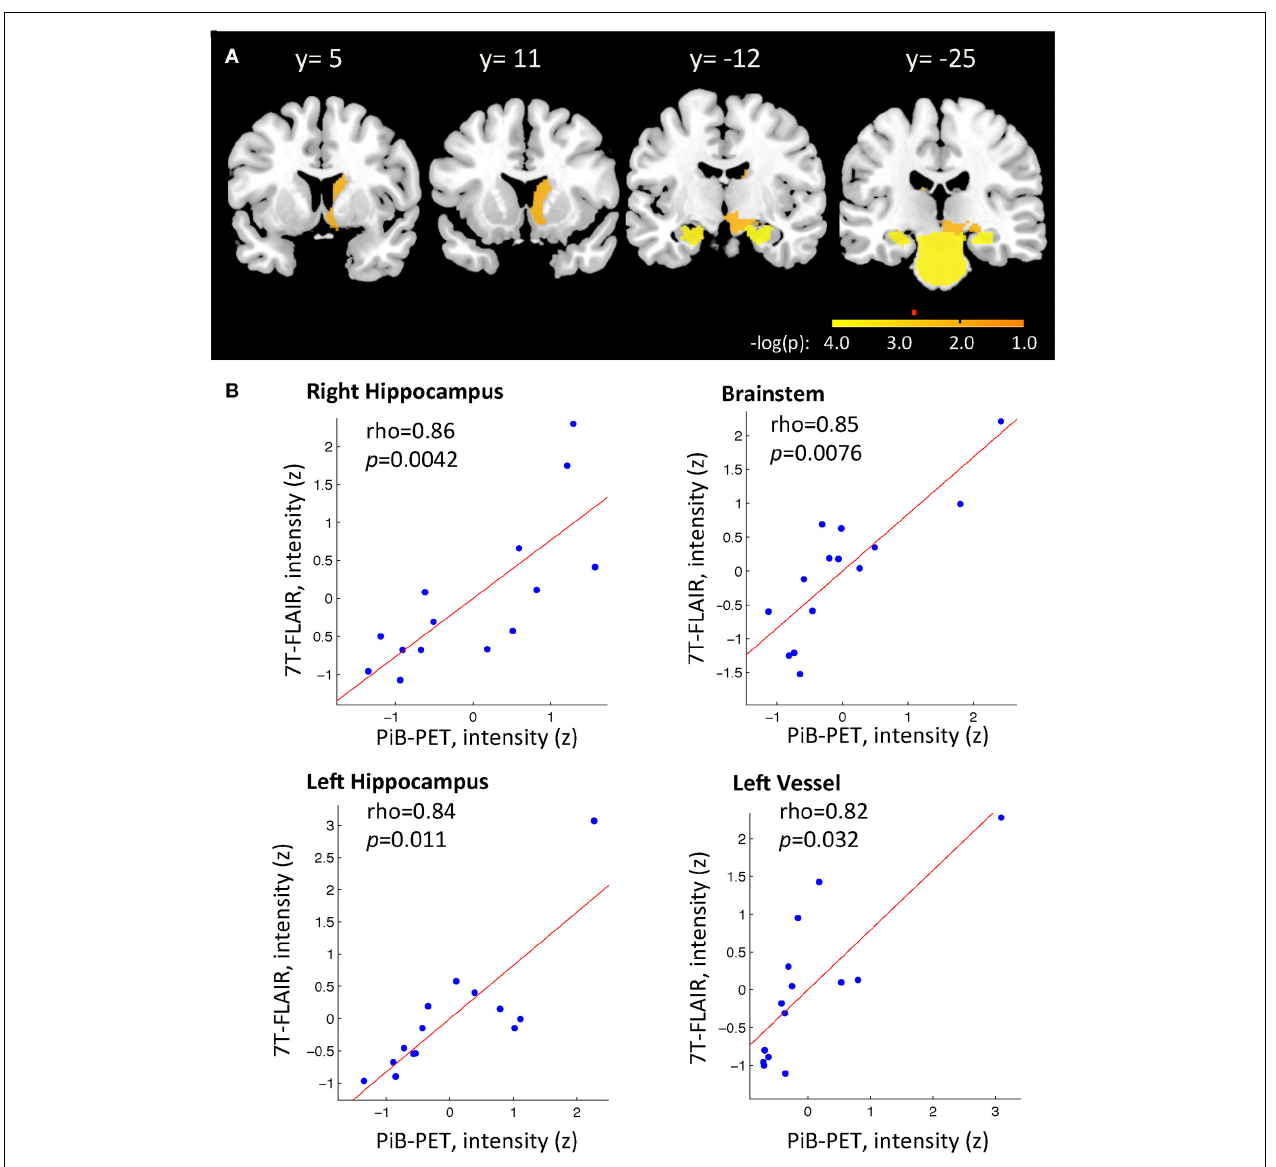
FIGURE 3 | (A) Relationship between individual regional PiB-PET and 7T FLAIR intensities as indicated by spearman correlation analysis. Displayed are regions with − log(p) > 1.3. Alpha = 0.05 after correction for multiple testing for ROIs with − log(p) > 2.7, as indicated by red marker. Y-positions refer to